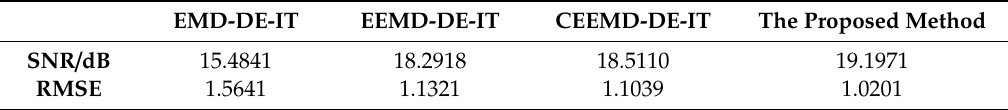
Table 4. Denoising result of the Chen’s signal when SNR is 11